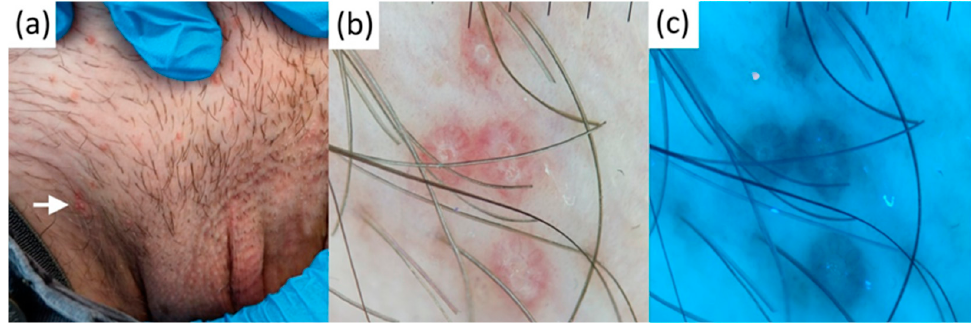
Figure 4. Clinical ( a ), contact-polarized ( b ), and ultraviolet-induced fluorescence ( c ) dermatoscopic images of genital molluscum contagiosum.